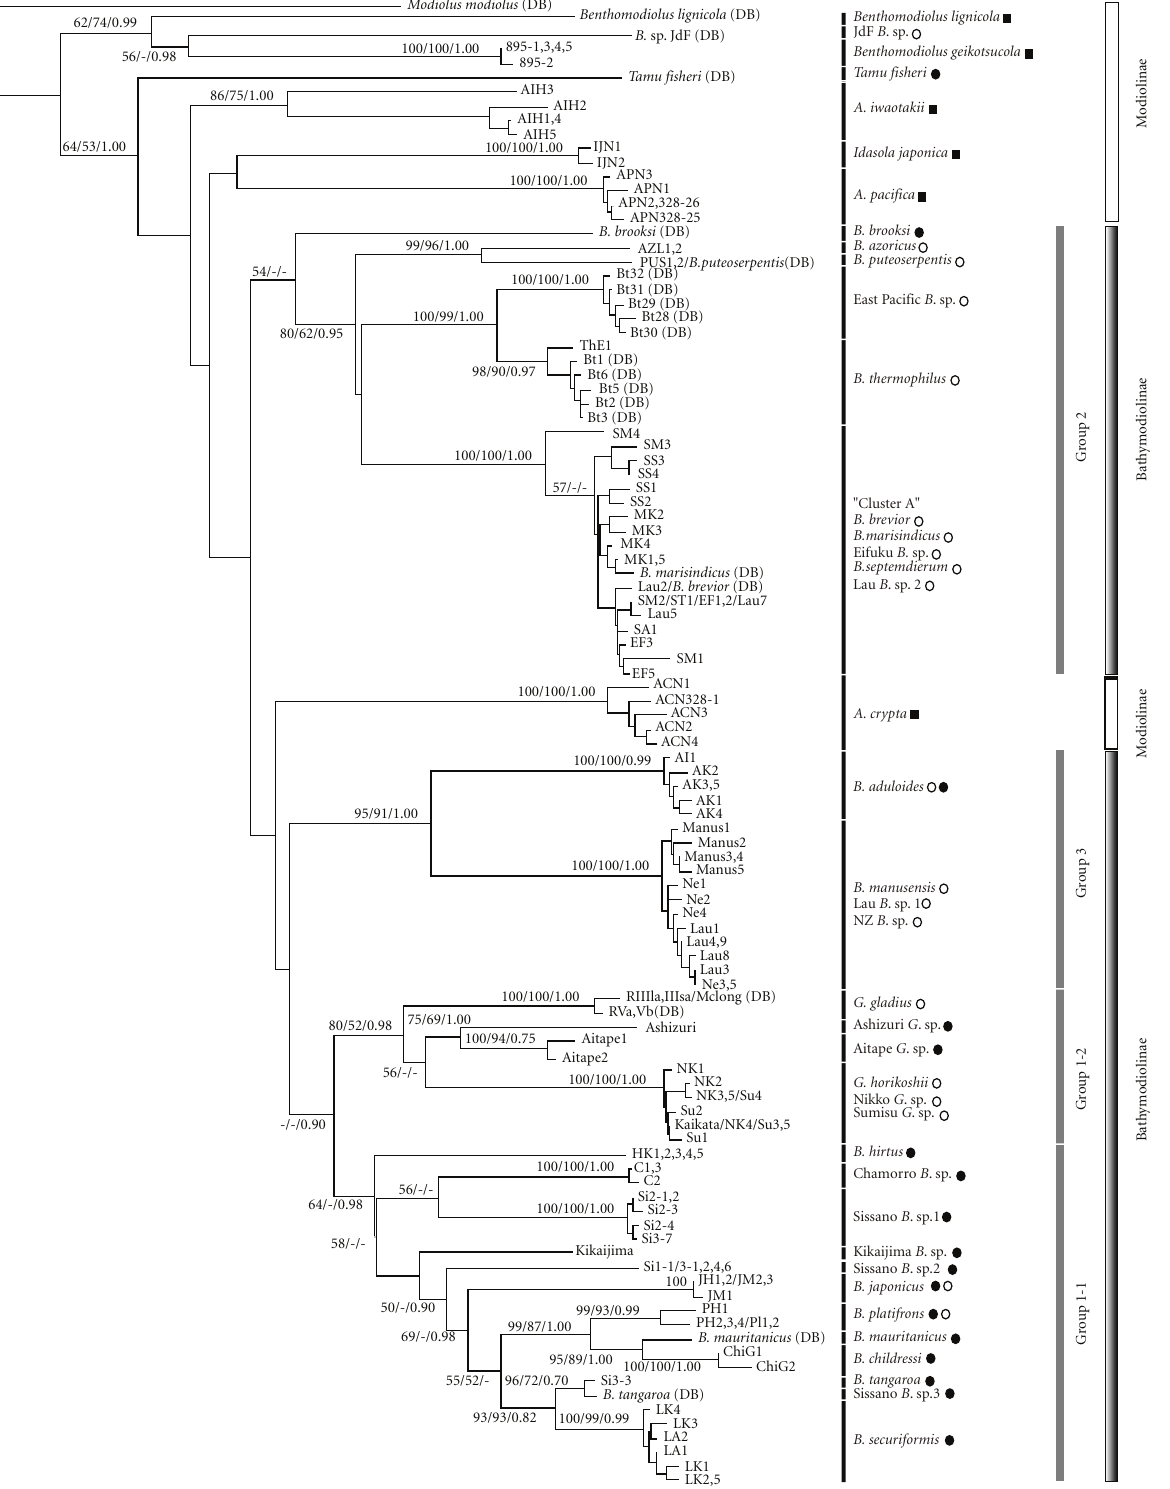
Figure 3: The phylogenetic relationships of the deep-sea Bathymodiolus mussels and their relatives based on the 401-bp mitochondrial COI sequences. The tree was modified from our published data [33] for reference. (cid:6) , hydrothermal vent; , cold-water seep; (cid:2) , wood/whale bone; (cid:3) , shallow. (c) Malacological Society of